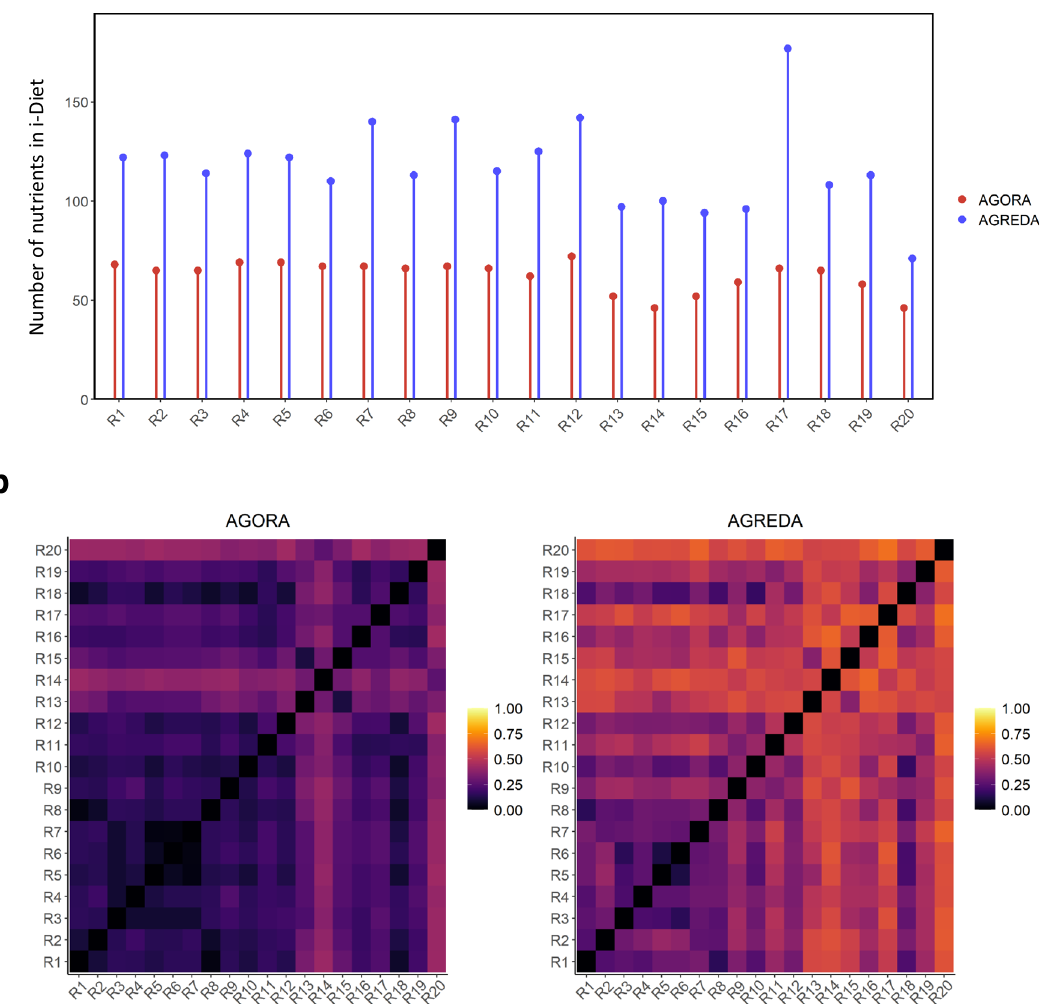
Fig. 3 Nutritional composition of 20 representative recipes of the Mediterranean diet in AGREDA and AGORA. a The number of input dietary nutrients that AGORA (red) and AGREDA (blue) capture for different recipes (R1, R2, … , R20). Note that all the metabolites present in AGORA are also included in AGREDA. b Differences between the nutritional content of the recipes captured by AGORA and AGREDA, respectively. The Jaccard ’ s distance between the compositions of the recipes is